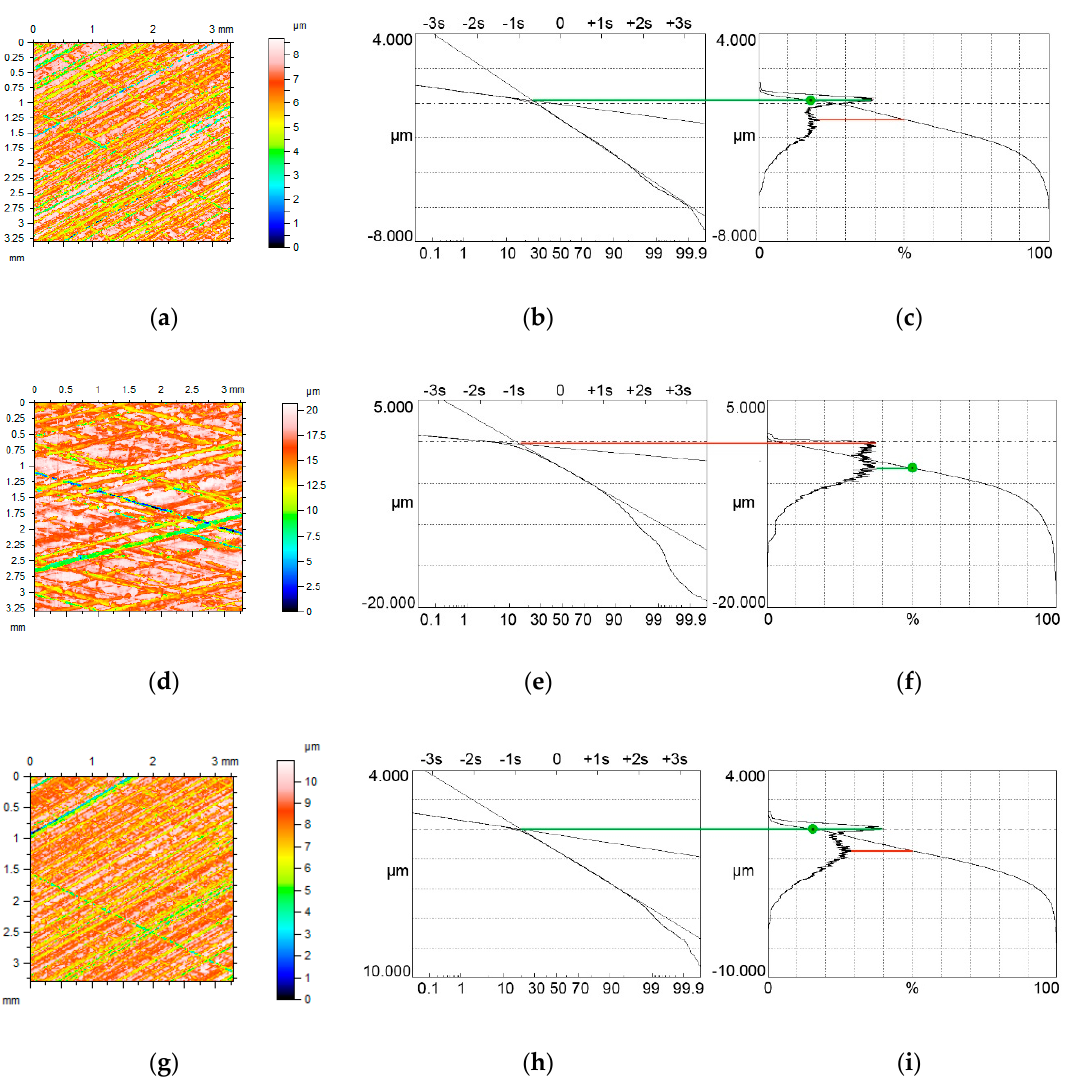
Figure 9. Contour plots ( a , d , g ) surface probability plot ( b , e , h ), material ratio curve and probability distribution ( c , f , i ) of two-process measured surfaces characterized by the following parameters: Spq = 0.31 µm, Svq = 1.61 µm, Smq = 24% ( a – c ), Spq = 0.49 µm, Svq = 2.89 µm, Smq = 15% ( d – f ) and Spq =